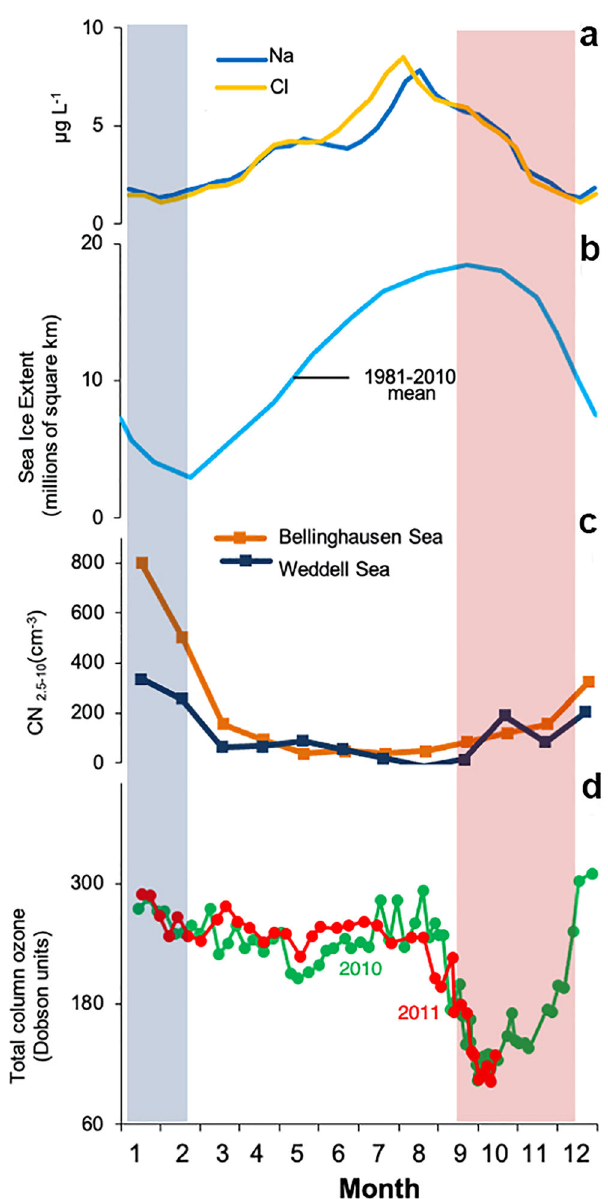
Fig. 6 Seasonal behavior in sea salt processing in Antarctica interconnection with geochemistry parameters. Monthly data of ( a ) Antarctica (Dome Summit South) seasonal variations for mean concentrations of Cl and Na 59 ; ( b ) Antarctic sea ice extent; ( c ) the concentration of aerosol particles (CN) between 2.5 and 10 nm in diameter in the Maritime Antarctica 60 ; and ( d ) monthly ozone column. Boxes are indicating periods when sulfatization (blue box) and heterogeneous reactions (red box) reach maximum